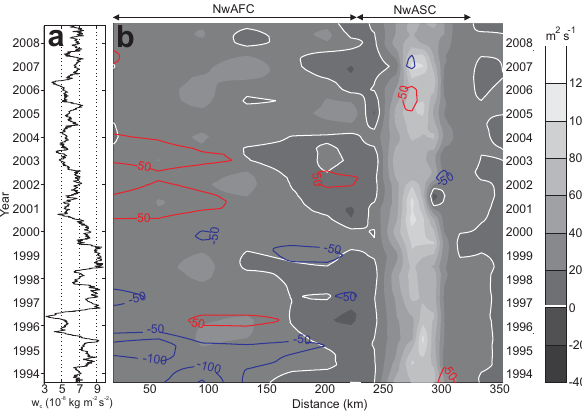
Fig. 6. (a) The averaged wind stress curl over the Norwegian Basin ( w c ). (b) Hovm¨oller diagram of vertically depth integrated velocity over the Atlantic water column as function of position in the sec- tion and time. Shaded contour intervals every 20m 2 s − 1 . White contours indicate zero flux. Red and blue lines are positive and negative anomalies of AW thickness (in metres), respectively. All values are one year moving